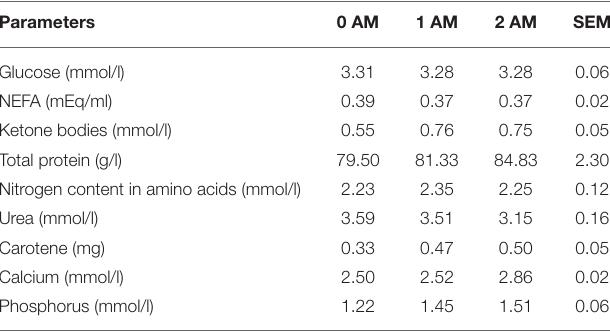
TABLE 8 | Content of milk protein fractions. Indicators